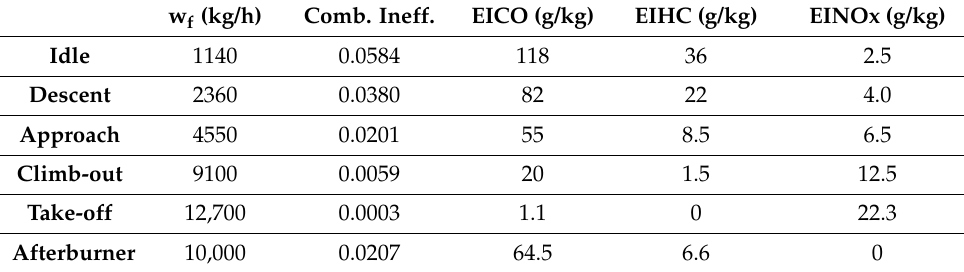
Table 4. Olympus engine emissions data along the reference LTO cycle [26].